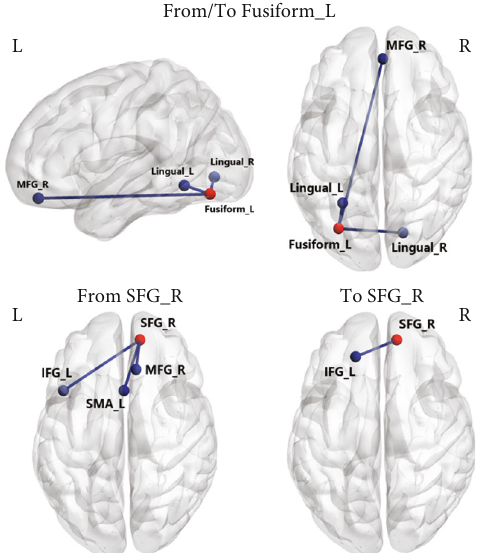
Figure 2: Altered e ff ective connectivity of left fusiform and right superior frontal gyrus in type 2 diabetes compared with healthy control ( P < 0 : 001 , uncorrected). IFG: inferior frontal gyrus; L: left; MFG: medial frontal gyrus; R: right; SFG: superior frontal gyrus; SMA: supplementary motor area.